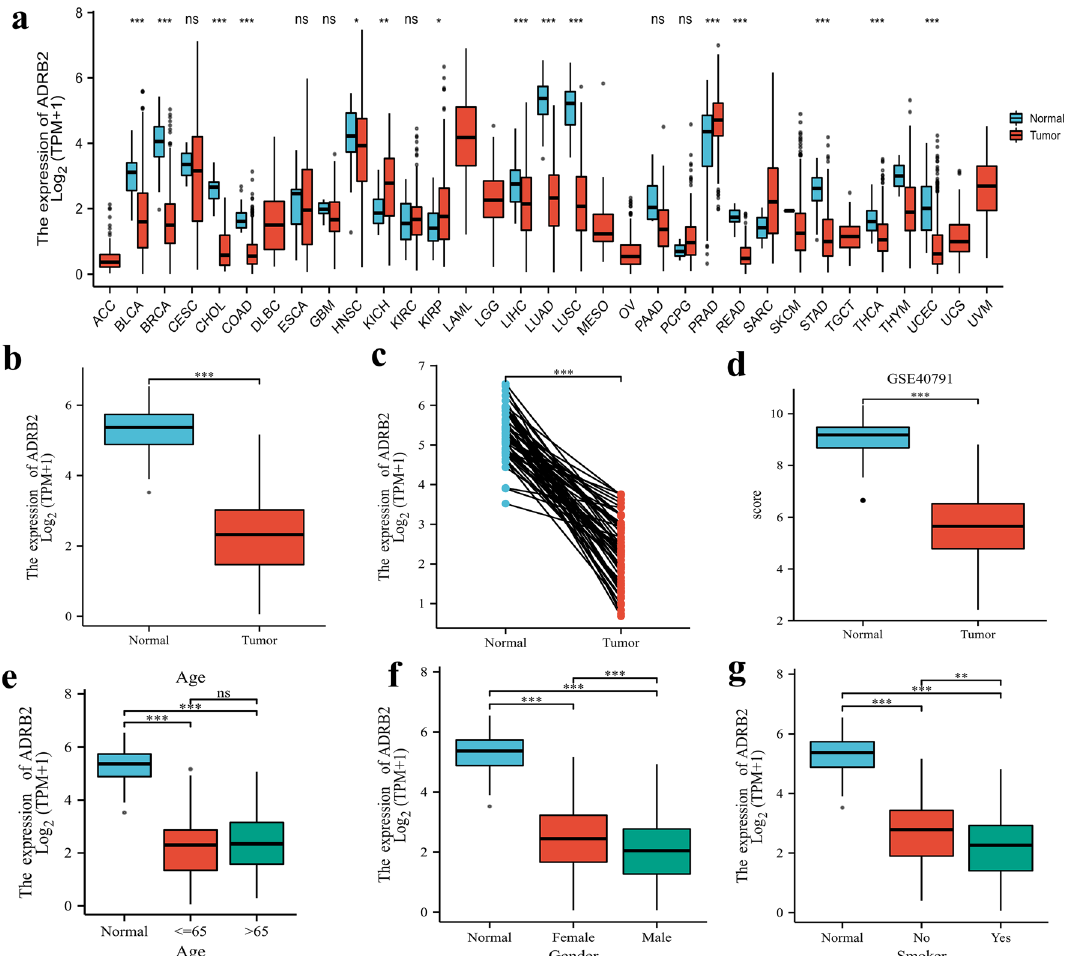
Figure 1. Relative expression level of ADRB2 in LUAD from TCGA database and GEO database. ( a ) ADRB2 mRNA expression levels in pan-cancers from TCGA database. ( b ) Boxplot of ADRB2 expression between the LUAD and normal tissues from TCGA database (Normal = 59 and Tumor = 535). ( c ) Pairwise boxplot of ADRB2 expression between the LUAD and normal tissues from TCGA database (Normal = 57 and Tumor = 57). The differential expression of ADRB2 in GSE40791 from GEO database (Normal = 100 and Tumor = 96) ( d ).The expression of ADRB2 is grouped by age ( e ), gender ( f ), and smoking status ( g ). ***P < 0.001, ns not comes (P < 0,001). Figure 1d shows 100 normal samples and 94 LUAD samples from the GEO database, which shows that ADRB2 is lowly expressed in LUAD patients (P < 0,001). ADRB2 expression in LUAD patients does not show correlation to age (Fig. 1e). Moreover, ADRB2 was significantly lower in males (P < 0.001, Fig. 1f) and in patients with a smoking history (P < 0.001, Fig. 1g). Association between ADRB2 and TNM stages in LUAD patients. To better understand the impact of ADRB2 on LUAD patient prognosis, Kruskal–Wallis analysis and Spearman correlation analysis were per- formed to determine the relationship between ADRB2 expression and clinicopathological characteristics (patho- logic and TNM stages). The ADRB2 expression was significantly decreased in LUAD patients, and was signifi- cantly correlated with pathological stage, T stage and N stage. (Fig. 2a–d, Supplementary Table S1). Relationship between ADRB2 and clinical characteristics. To further investigate the mechanism of ADRB2 in LUAD, the associations between ADRB2 expression and clinical characteristics were investigated. Based on the clinical data of 535 patients with LUAD, logistic regression analysis indicated that the expression level of ADRB2 in LUAD was negatively correlated with gender (OR 0.603 for males vs. females, P = 0.004); smoking status (OR 0.457 for yes vs. no, P = 0.003); T classification (OR 0.581 for T2 vs. T1, P = 0.005; OR 0.308 for T3 vs. T1, P < 0.001; OR 0.293 for T4 vs. T1, P = 0.018); and pathologic stage (OR 0.527 for stage III vs. stage I, P = 0.011, Fig. 3).